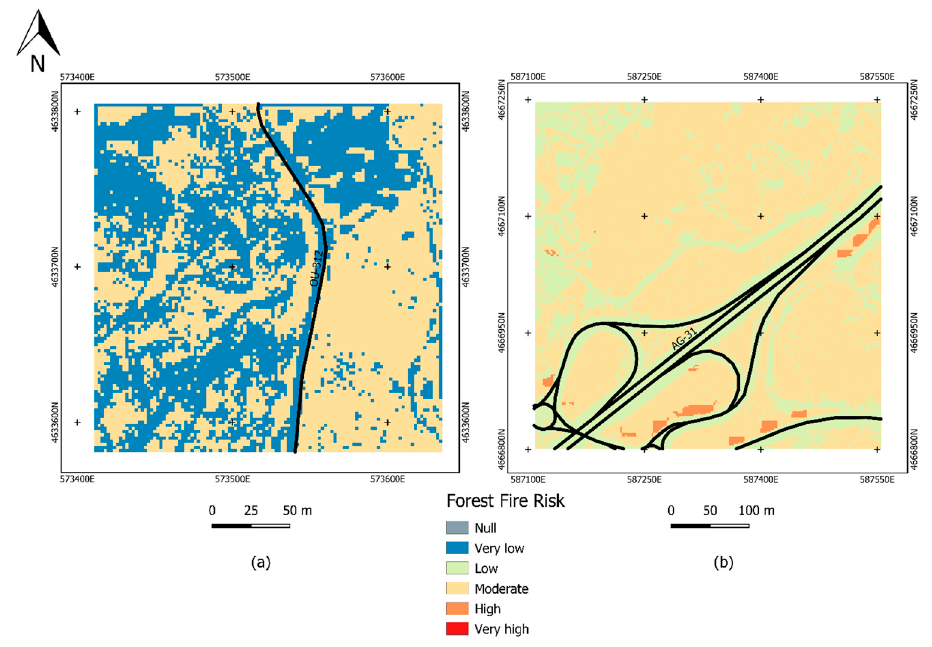
Figure 10. Forest fire risk map. ( a ) Forest fire risk map of study area A; ( b ) forest fire risk map of study area B. The map coordinate system is EPSG:25829 ETRS89/UTM zone 29N.